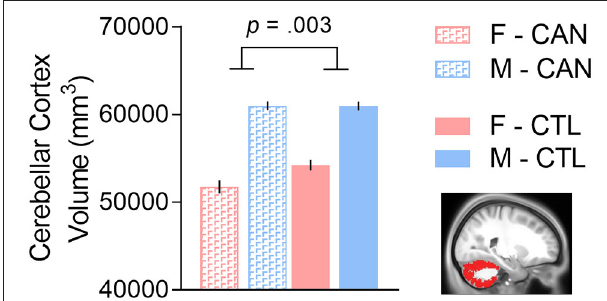
FIGURE 1 | There was a cannabis group-by-sex interaction in cerebellar cortex volume, such that females with a history of chronic cannabis use had smaller volumes than the other groups. We controlled for tobacco usage and total intracranial volume in the analysis. F, Female; M, Male; CAN, Chronic cannabis use group; CTL, control group.